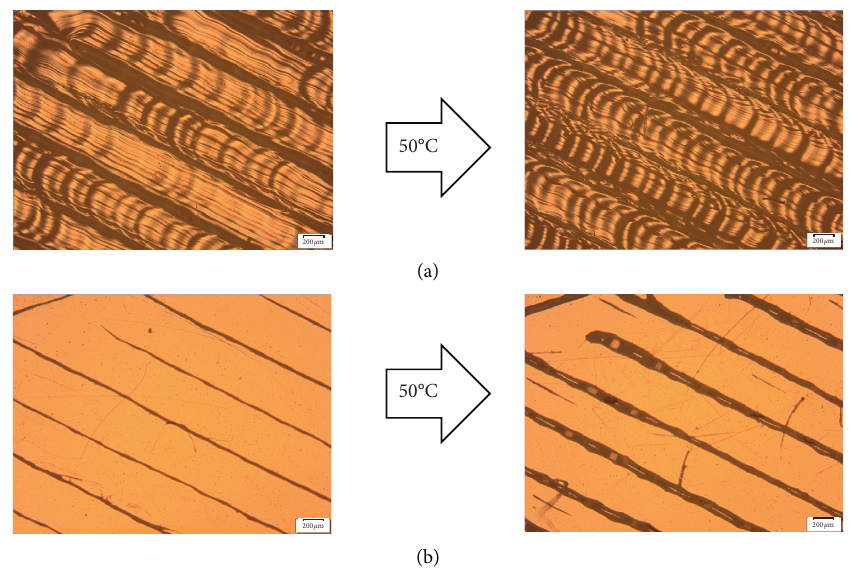
Figure 8: Microscopic images: top side of the filament (a) and bottom side of the filament (b).